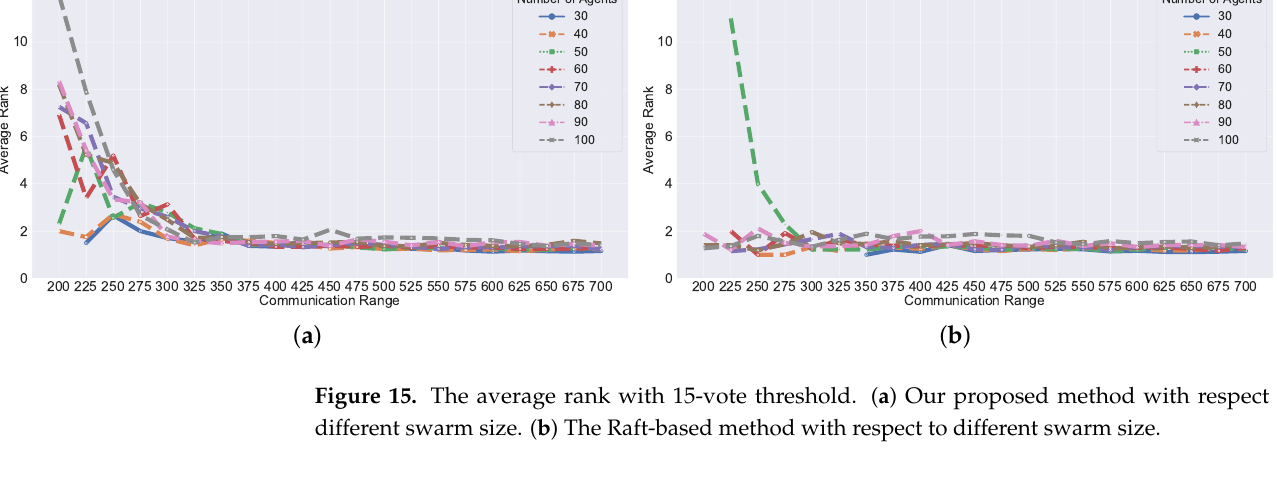
Figure 14. The election success rate at top-1 with half swarm size threshold. ( a ) Our proposed method with respect to different swarm size. ( b ) The Raft-based method with respect to different swarm size.